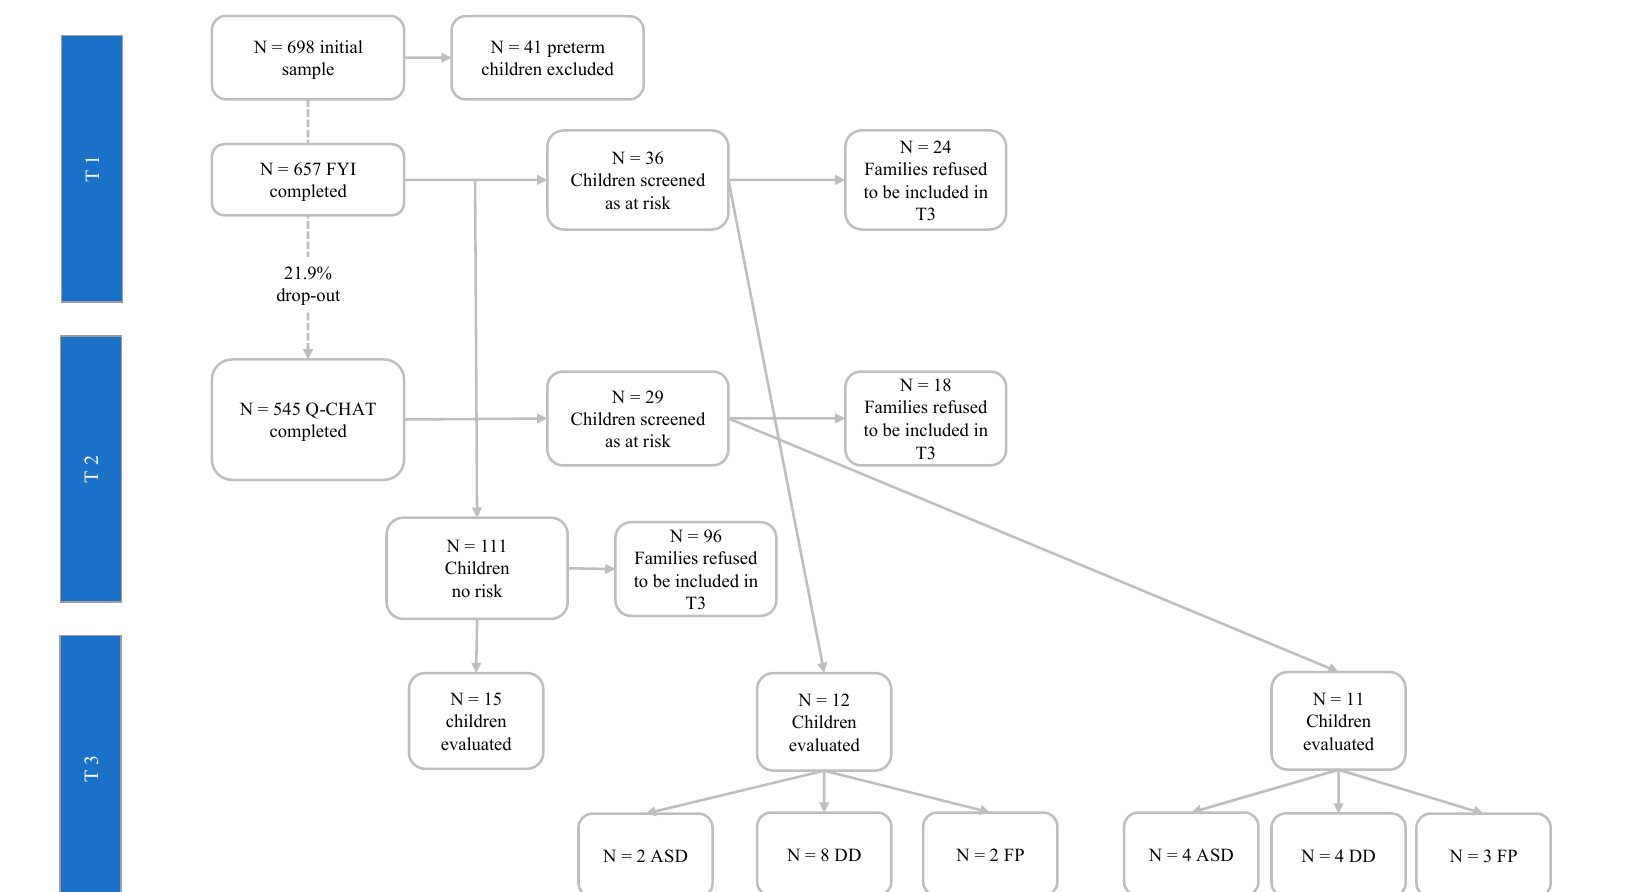
Figure 1. Flowchart of the longitudinal study design. ASD: Autism Spectrum Disorder; DD: developmental disorder; FP: false positive.